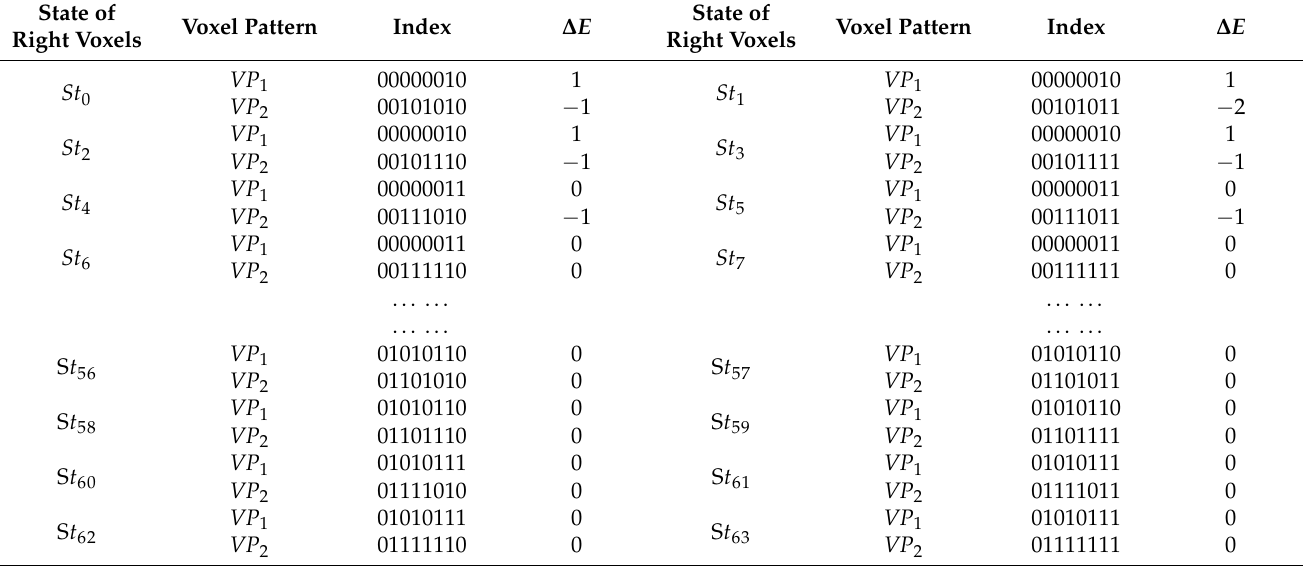
Table 3. The Euler number increment of a voxel pattern whose left six voxels are St 7